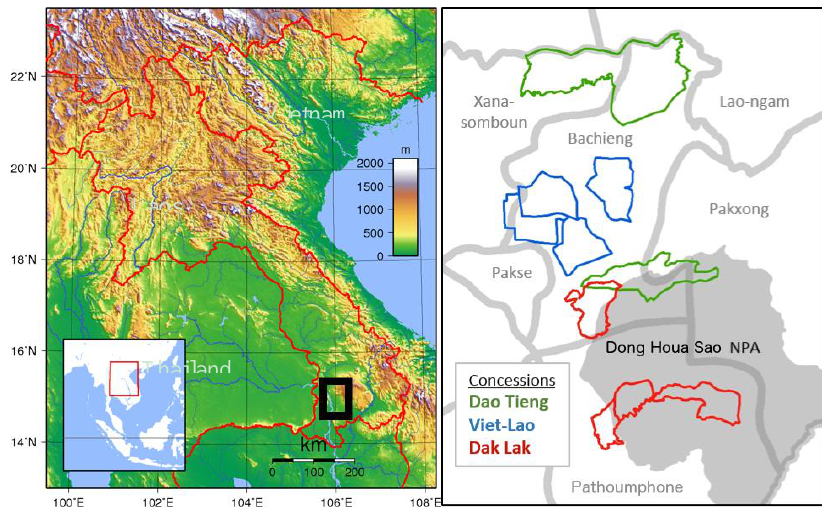
Figure 1. Study area with the three planned concession locations. District boundaries and names are in light gray. See note for concession location sources.